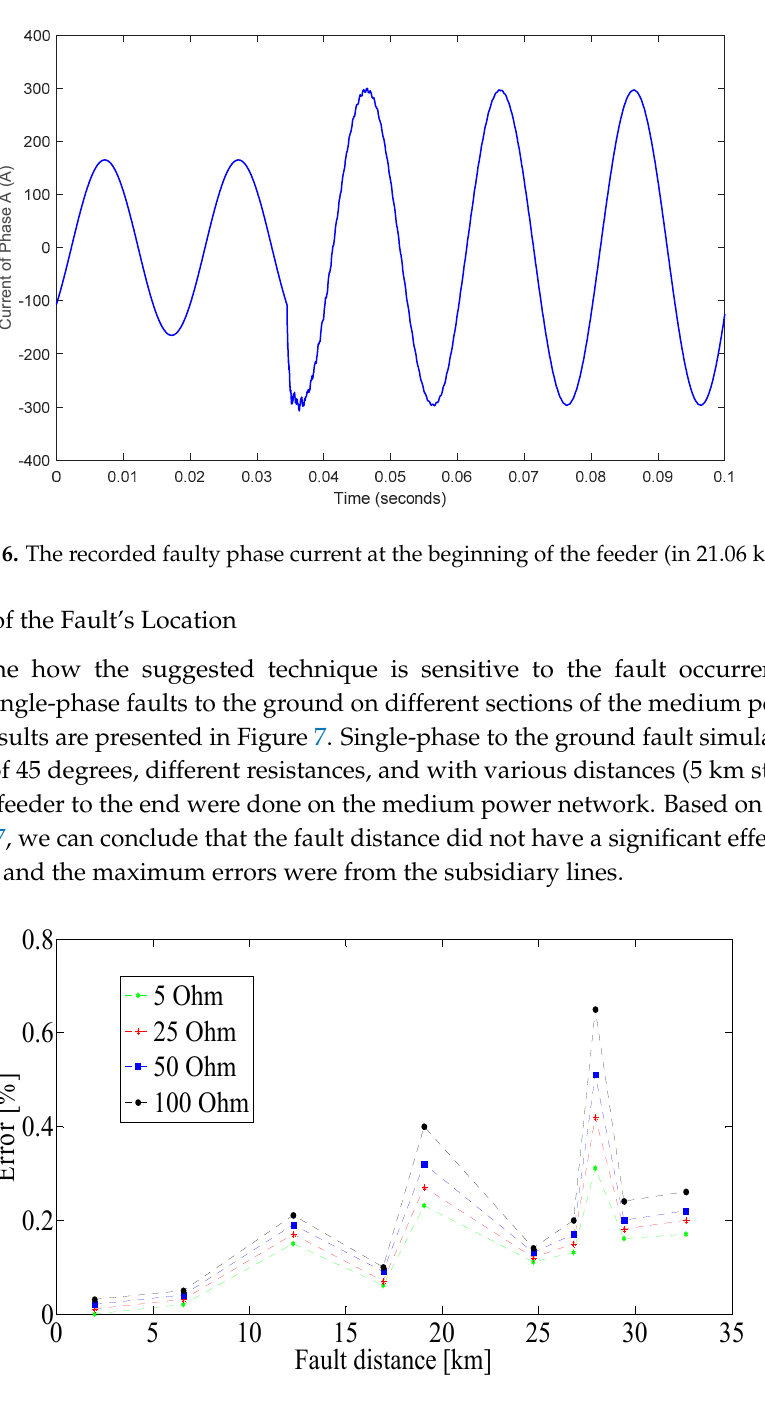
Figure 7. Error percentage of the proposed method for various resistances and different locations.